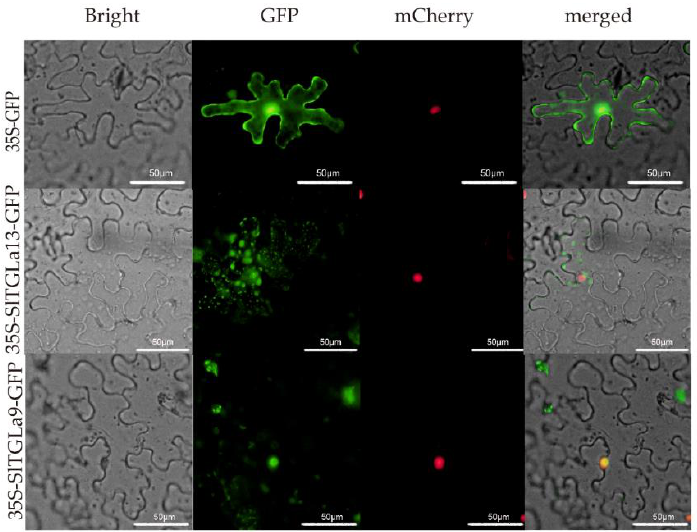
Figure 8. Subcellular localization of two GFP-fused SlTGL proteins. mCherry is a red fluorescent protein (RFP) fused with the nucleus marker, indicating nuclei. Merge indicates merger between the GFP and mCherry fluorescence images. Scale bars, 50 µm.